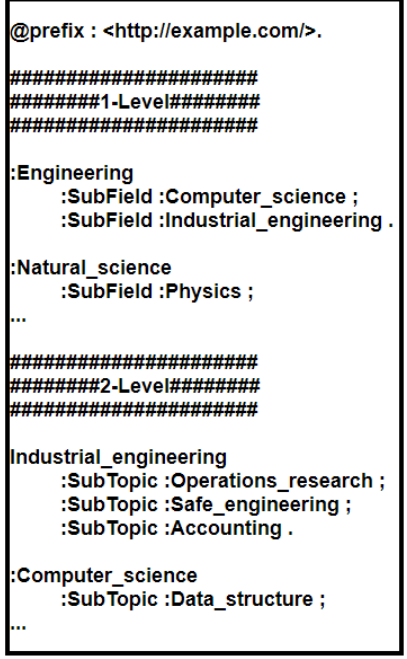
Figure 8. An example of information taxonomy defined in